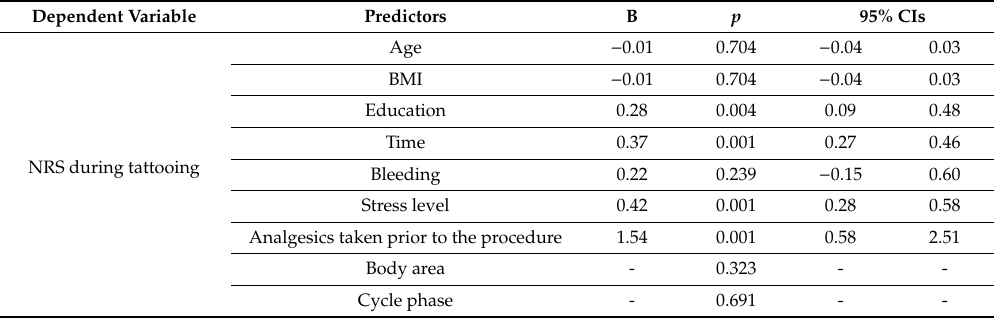
Table 3. Results of regression analyses including cycle phase and excluding